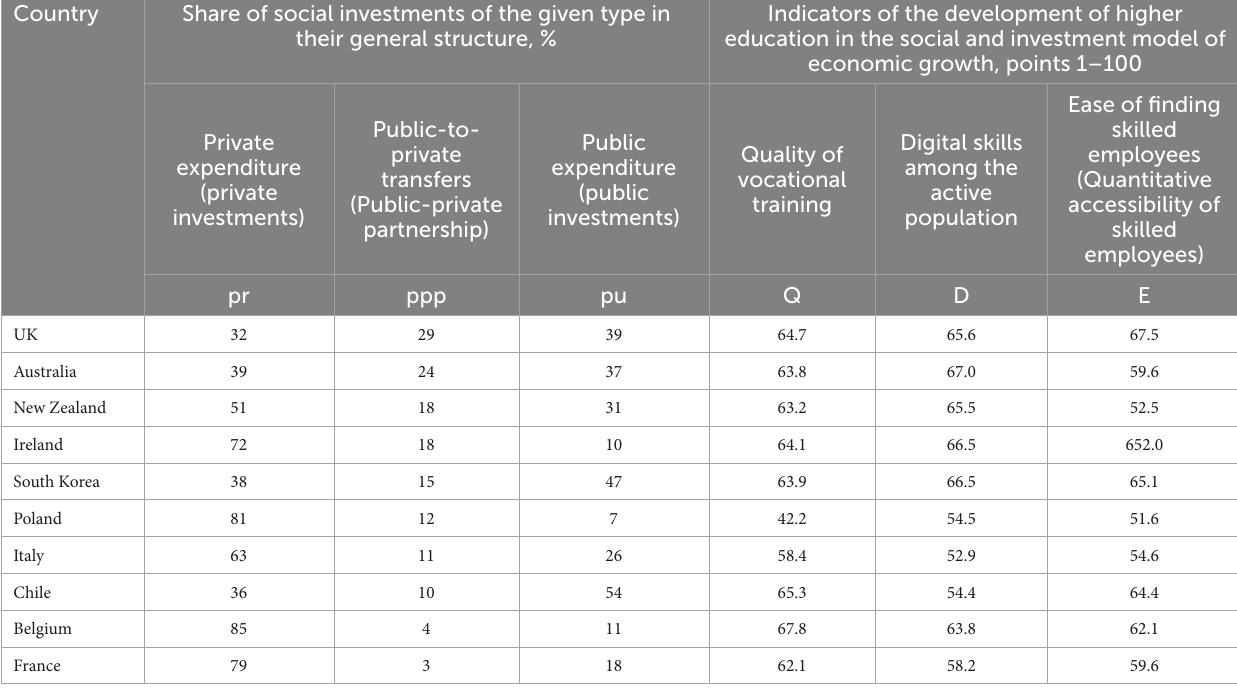
TABLE 1 The structure of investments in higher education and the indicators of its development in the countries of the sample in 2020. Country Share of social investments of the given type in Indicators of the development of higher their general structure, % education in the social and investment model